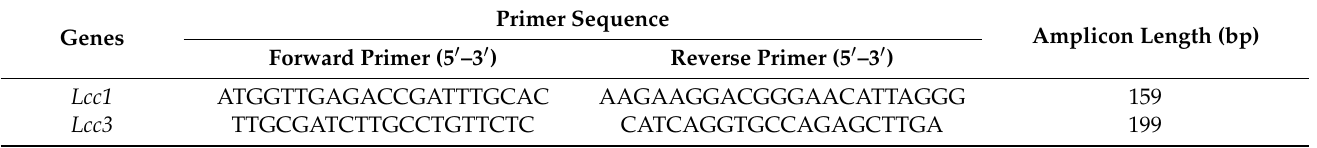
Table 1. List of primers used for the qRT-PCR of Lcc genes in this study. Primer Genes